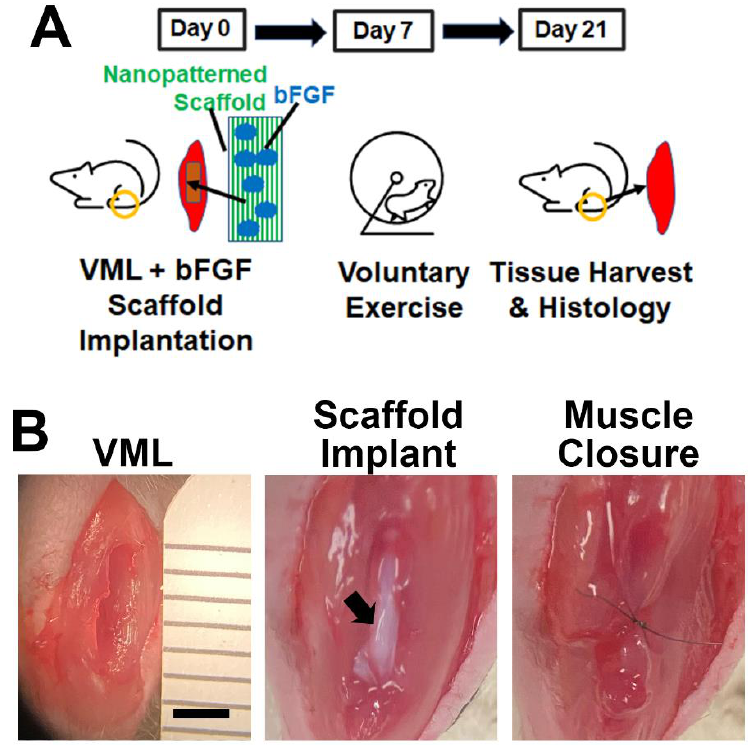
Figure 3. Overview of experimental design and surgical procedure. ( A ). Timeline of the study showing induction of VML and scaffold implantation on day 0. On day 7, specified treatment groups received caged wheel voluntary exercise for 2 weeks. On day 21, the tissues were harvested for histology. ( B ). Surgical images show full thickness VML, scaffold implantation, and muscle closure over the scaffold. Arrow denotes scaffold. Scale bar: 2 mm.